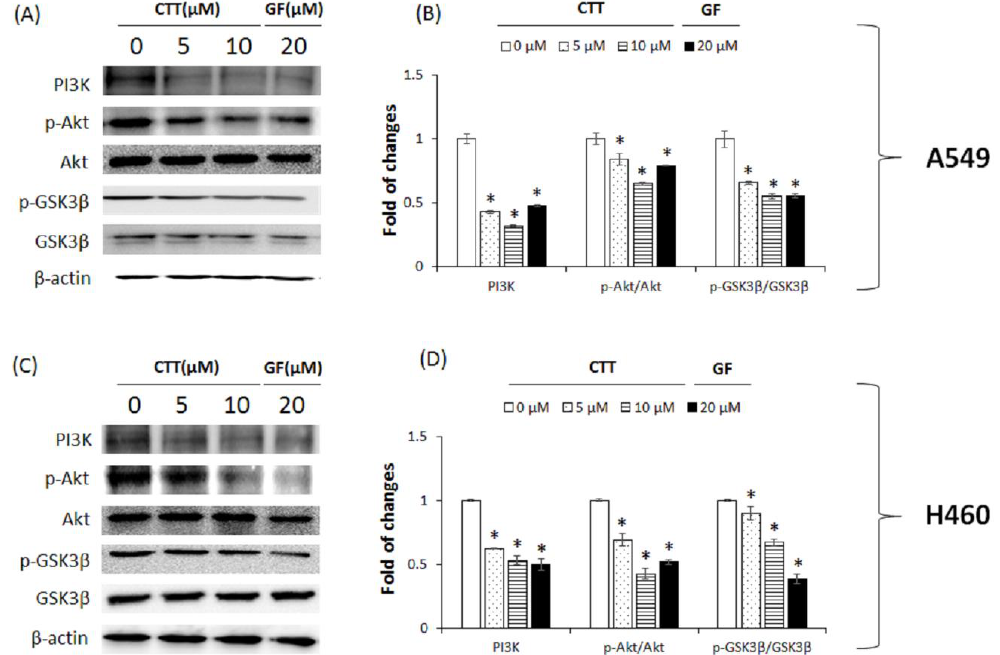
Figure 7. Effects of CTT treatment on the expression of PI3K/Akt/GSK-3β pathway proteins in A549 and H460 cells. ( A , C ) After treatment with 0, 5, or 10 μM of CTT or 20 μM GF (clinical anticancer drug) for 20 h, the protein levels of PI3K, p-Akt/Akt, p-GSK3β/GSK3β were determined